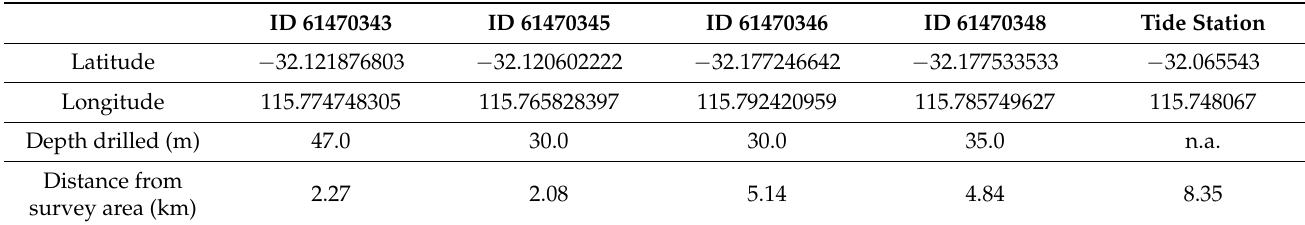
Table 1. Summary of position information, drilled depths, and distance from the survey area of the groundwater wells and tide station.